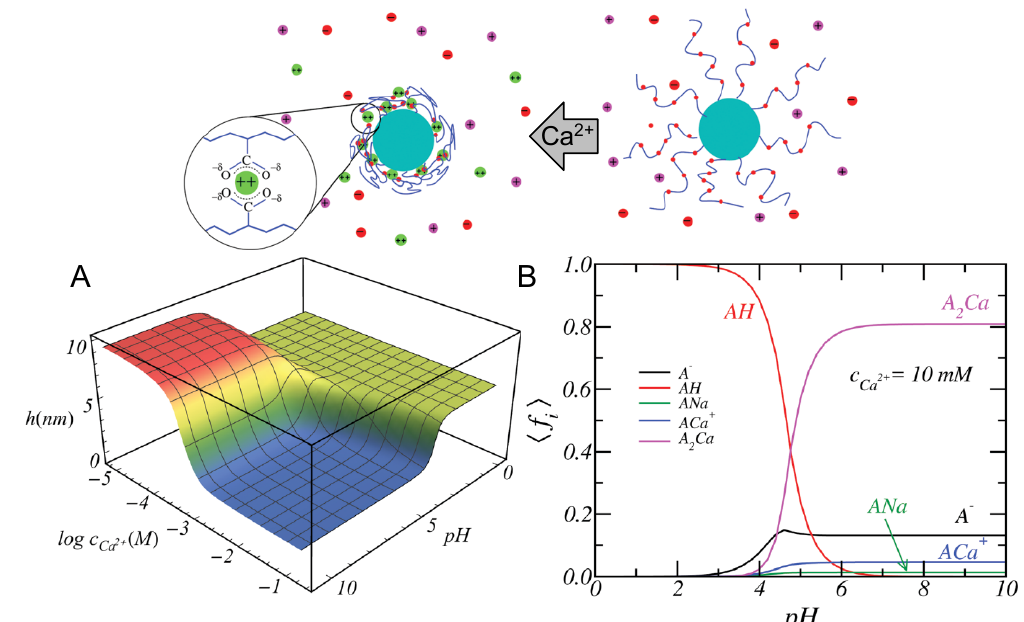
Figure 7. (upper panel) Illustration of the effect that calcium ions can have on the structure of a poly(acrylic acid) layer grafted to a NP. The inset shows the bridge formed between one calcium ion and two carboxylic acid monomers. ( A ) Height of the poly(acrylic acid) layer as a function of the bulk pH and Ca 2 + concentration. ( B ) Average fraction of A − , AH, ANa, ACa + , and A 2 Ca as a function of pH for a 10 mM concentration of of Ca 2 + ions in solutions. The NaCl concentration is 150 mM (physiological conditions). In all figures, the NP radius is R = 4 nm, the surface coverage is σ = 0.15 nm − 2 , and the number of monomers is N = 50. (Reprinted with permission from the authors of [30]. Copyright 2018 The Royal Society of